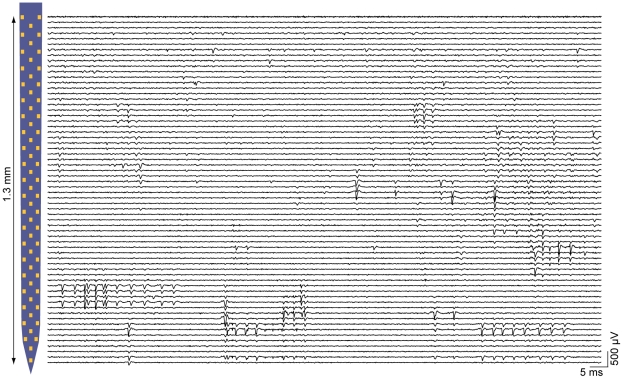
Parallel recording capabilities of the multiplexed electrophysiology system.Traces are filtered from 0.3–5 kHz to highlight spiking activity, and are plotted near their corresponding location on the shaft of the probe displayed on the left (for each horizontal left-right pair of pads, the trace for the left-hand pad appears just above the trace for the right-hand probe). Measurements were made in the mouse thalamus with a probe with post-plating impedances of 0.6±0.4 MΩ (mean±1 s.d.). The majority of sites report action potentials, and only one of the 64 sites (uppermost trace) is non-functional.